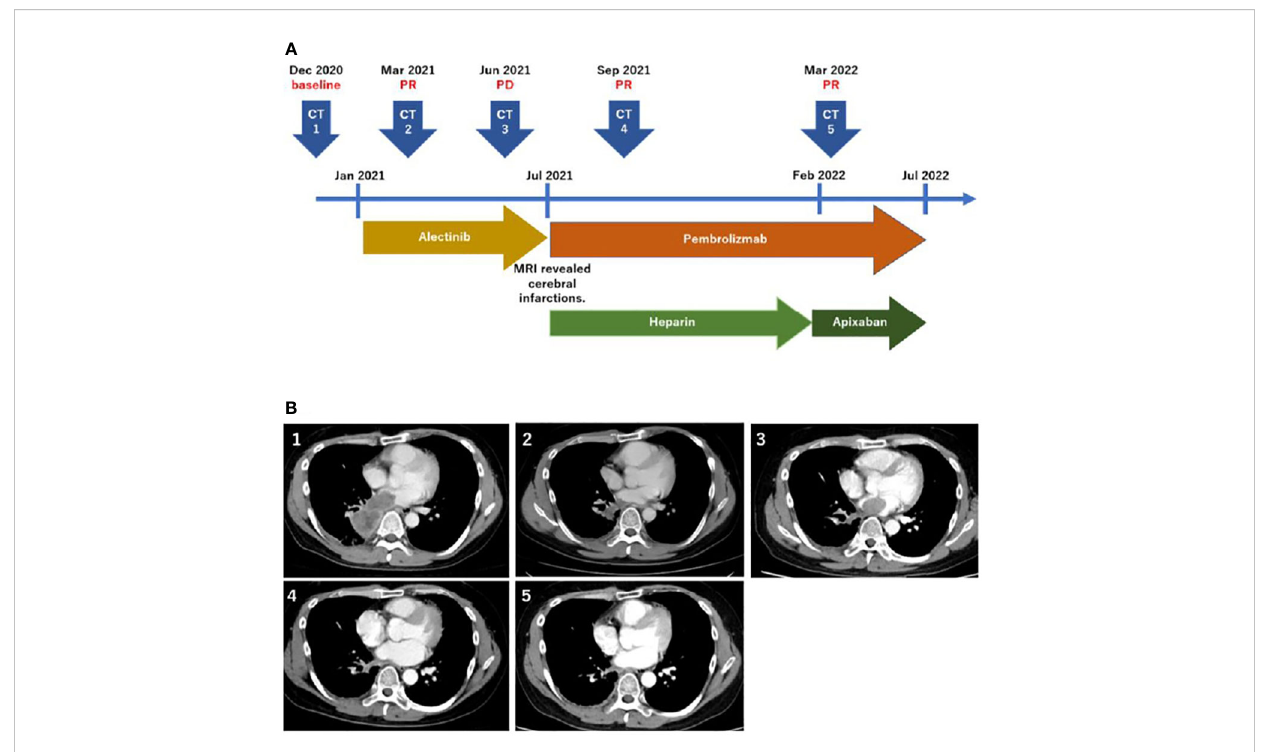
FIGURE 1 Timeline of the treatment and disease course (A) . Computed tomography scans corresponding to the timeline (B)